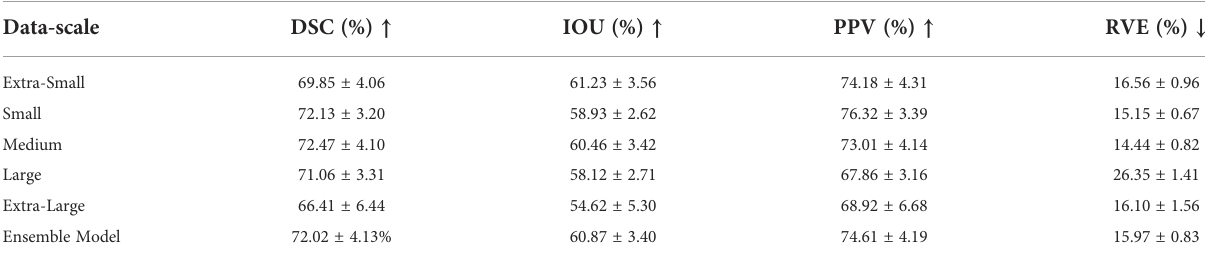
TABLE 4 Model ensemble performance for DSC, IOU, PPV and RVE, where each data scale corresponds to a separate and unique model trained on that speci fi c data